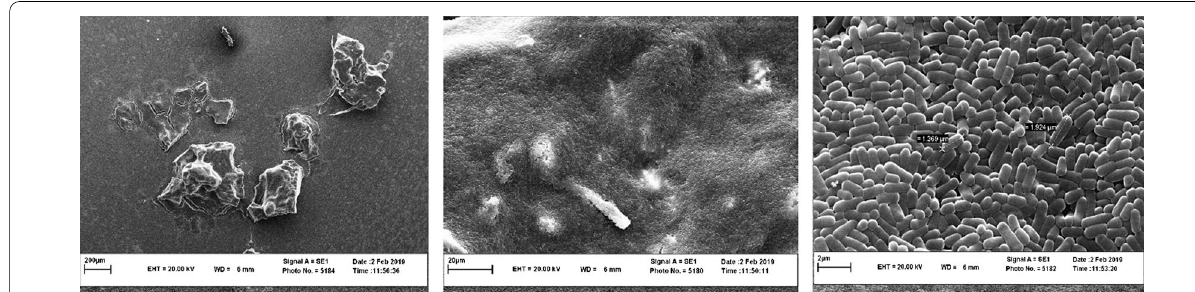
Fig. 4 Scanning electron microscopy images of biofilm-forming L. rhamnosus in